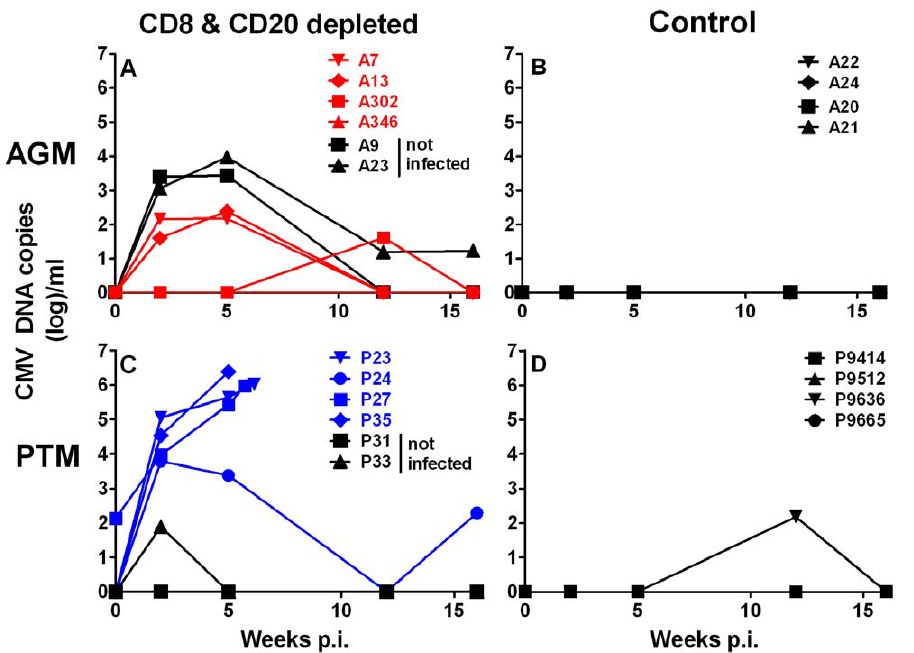
Figure 6. CD8 + and CD20 + lymphocyte depletion results in CMV reactivation in AGM and PTM. CMV DNA copies in plasma of vervet AGM ( A ) and PTM ( C ) are shown graphically for animals not infected with SIV agm but depleted of CD8 + and CD20 + lymphocytes (black symbols), and animals that were depleted of CD8 + and CD20 + lymphocytes and SIV agmVer90 -infected (red for vervet AGM, blue for PTM). For comparison, historic SIV-infected control AGM ( B ) and PTM ( D ) that did not receive administrations of mAbs are shown. The median values of six replicates for sequential plasma samples at each time point from each animal are shown.